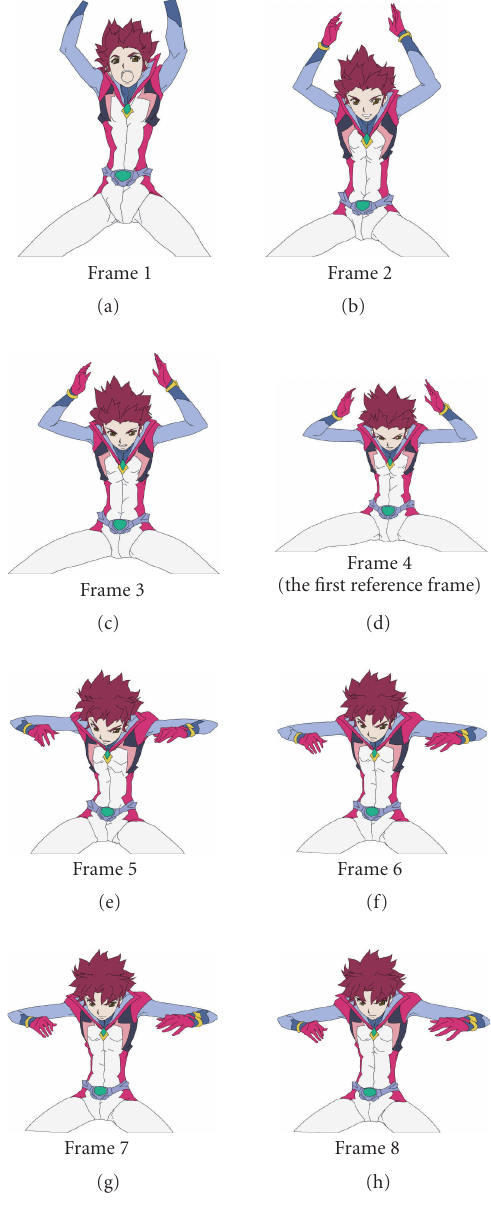
Figure 9: Test 1 (resolution: 2420 × 2420 pixels) (courtesy of Anime International Co., Inc.,